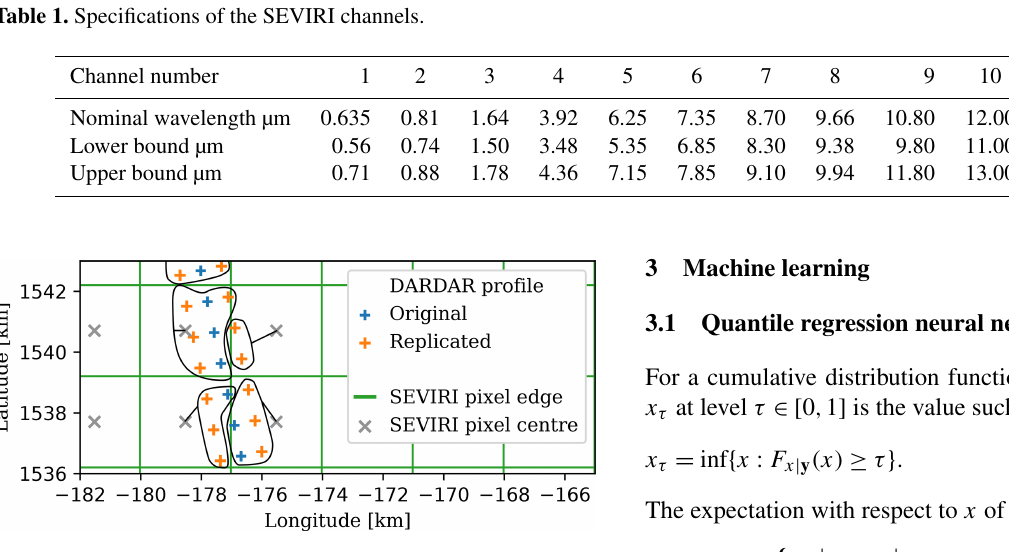
Figure 1. Illustration of the spatial resampling performed. The pro- jection used is the SEVIRI projection. Note that the units of the coordinates are kilometres. The DARDAR profiles are replicated from the profile in the centre of the track to the swath edges 700m on each side. The curves enclose the profiles used to derive the av- eraged values in each cell.